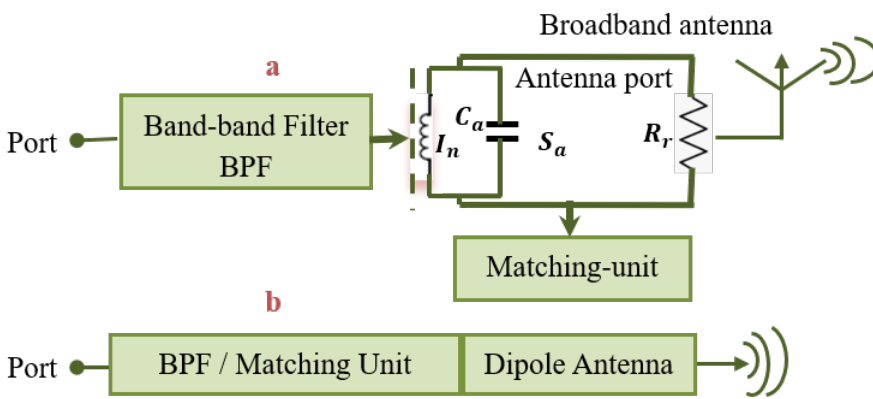
Fig. 1. BPF and antenna in a front-end: (a) Traditional; (b)